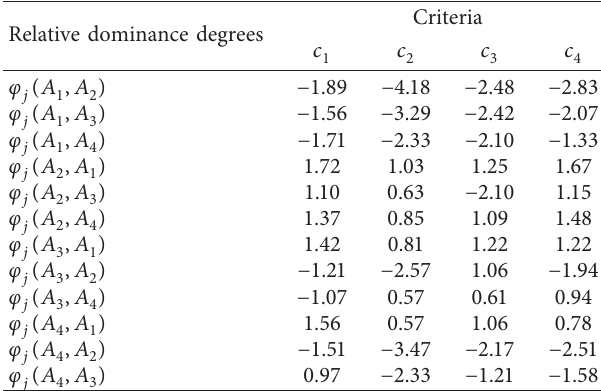
Table 15: Relative prospect dominance